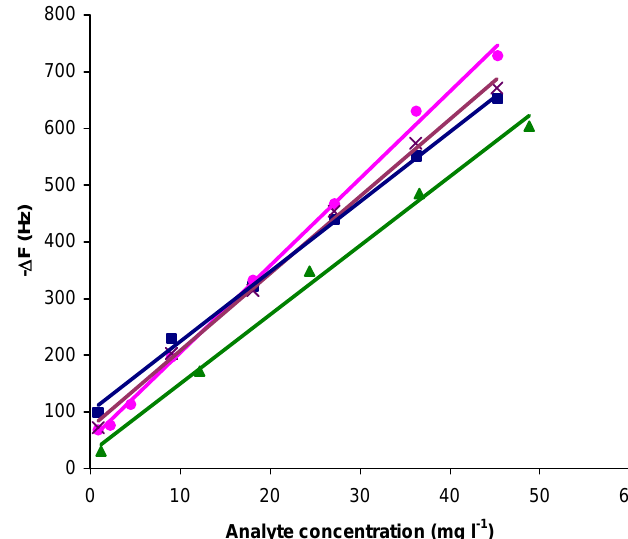
Figure 6. Calibration curves for determination of benzene ( ■ ), toluene ( ● ), ethylbenzene ( ▲ ) and xylene ( × ) using polystyrene-coated quartz crystal electrode. Polymer cast from a 0.5% (w/v) of polystyrene / chloroform solution.